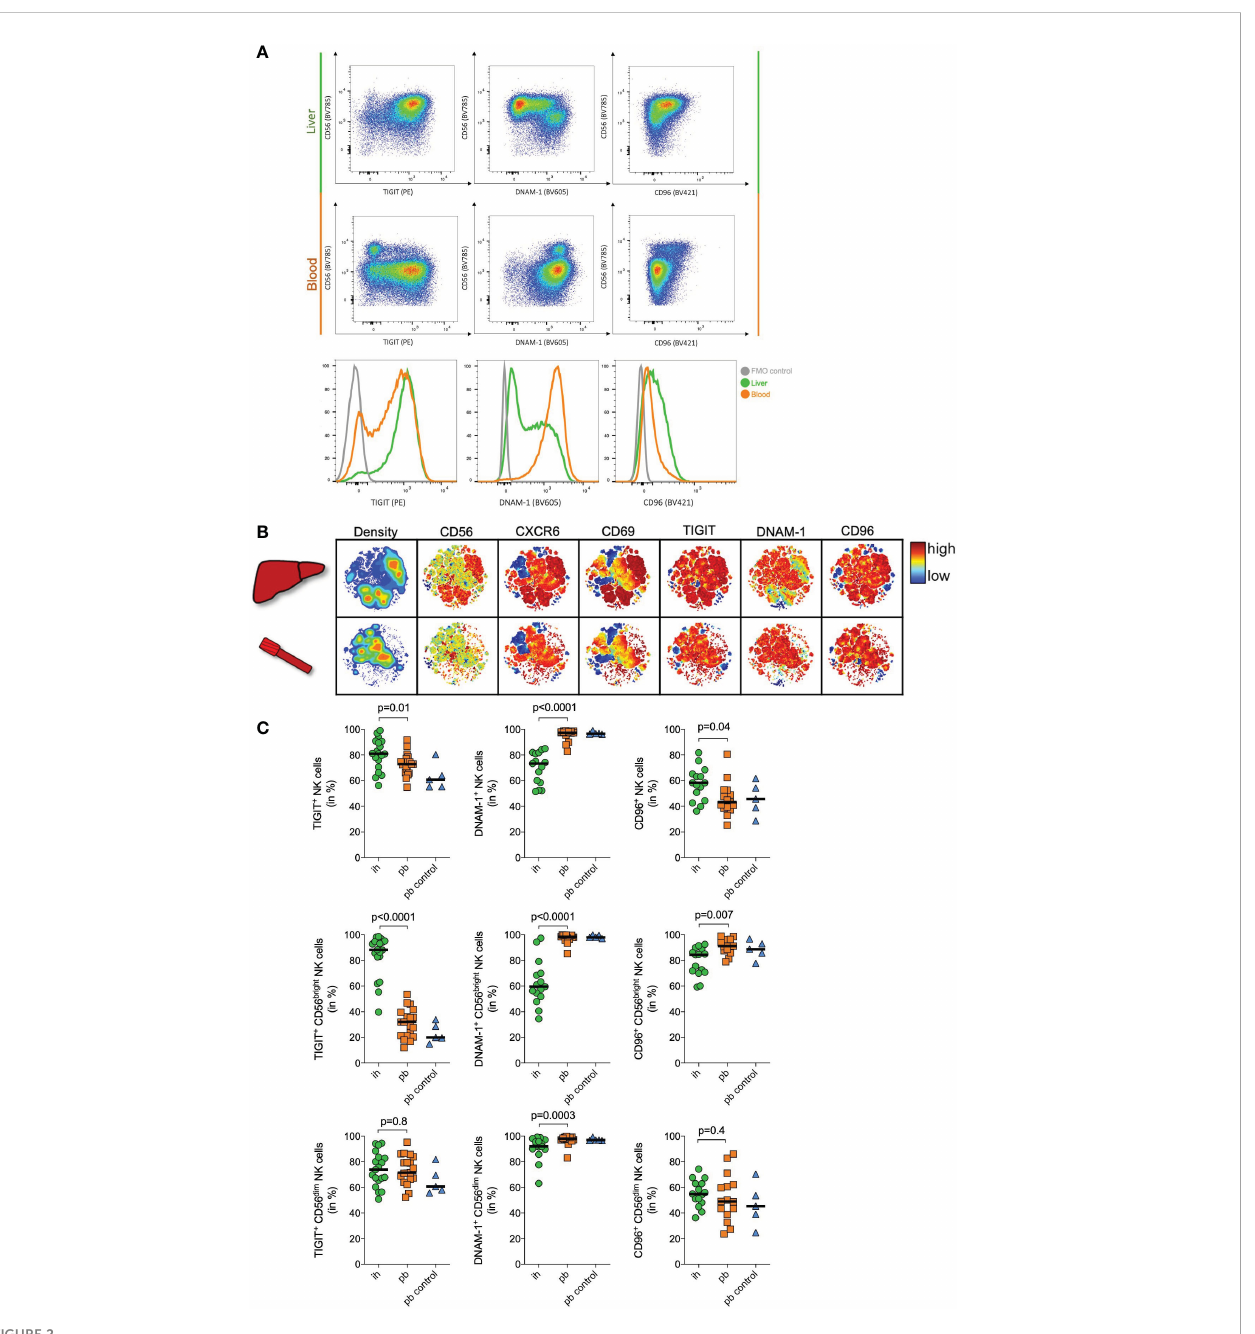
FIGURE 2 Immunophenotyping of NK cells. (A) Representative plots of fl ow cytometry data of one donor showing TIGIT, DNAM-1 and CD96 expression on peripheral blood (pb) and intrahepatic (ih) bulk NK cells. Histogram showing TIGIT (left), DNAM-1 (middle) and CD96 (right) expression on bulk NK cells in the liver (green), the blood (orange) and a FMO control (grey). (B) Representative viSNE plots showing density and the expression of CD56, CXCR6, CD69, TIGIT, DNAM-1 and CD96 on ih and pbNK cells from one patient undergoing liver transplantation. Color coding indicates the density and marker expression. viSNE analysis was performed using Cytobank. (C) Quantitative analysis of fl ow cytometry data of matched ih and pbNK cells from liver resection patients (n=15 for DNAM1- and CD96, n=19 for TIGIT), and control pbNK cells from healthy individuals (n=5) showing TIGIT, DNAM-1 and CD96 expression on bulk, CD56 dim and CD56 bright NK cells. Green dots representing ihNK cells, orange squares representing pbNK cells and blue triangles representing healthy control pbNK cells. Wilcoxon matched-pairs sign rank test was used to determine statistical differences between ih and pbNKcells in all scatter plots, Mann-Whitney test was used to determine statistical differences between pb and pb control NK cells in all scatter plots. Black line indicates